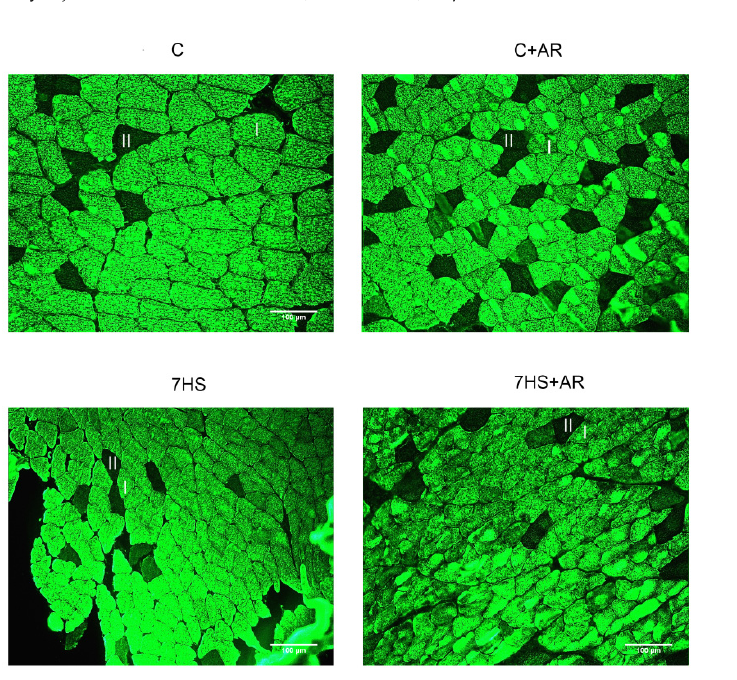
Table 2. Changes in the mean CSA of slow-type (I) and fast-type (II) soleus muscle fibers. Groups CSA of Type I Fibers, μ m 2 CSA of Type II Fibers, μ m 2 C 3648 ± 244 2918 ± 68 C + AR 3300 ± 301 3049 ± 184 7HS 2182 ± 92 * 2130 ± 229 * 7HS + AR 2831 ± 414 1951 ± 163 * Values are means ± SEM. C, vivarium control group, C + AR, vivarium control rats + daily injections of GSK-3 inhibitor (AR-A014418) for 7 days, 7HS, hindlimb suspension for 7 days, 7HS + AR, 7-day hindlimb suspension + daily injections of GSK-3 inhibitor (AR-A014418), *: p < 0.05 vs. C.